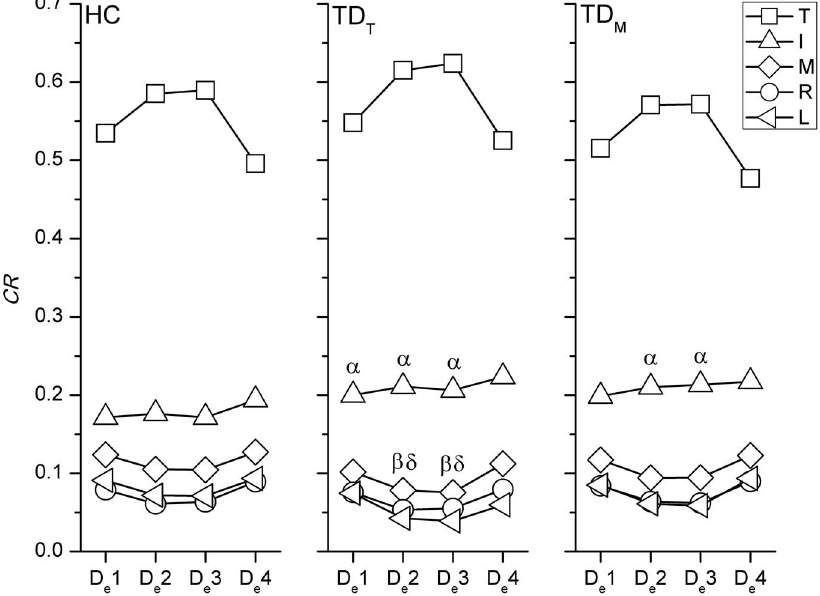
Figure 6. The significant difference of CR between TD I and HC during drinking. The force contribution ratios of each digit during the holding task in HC, TD T and TD M . A higher CR of the index finger and lower CR of the middle and little fingers were noticed in TD I and TD M . Significant differences ( p , 0.05) in CR with regard to specific digits between HC and TD groups are indicated by the following symbols: a means the index finger, b means the middle finger and d means the little finger.